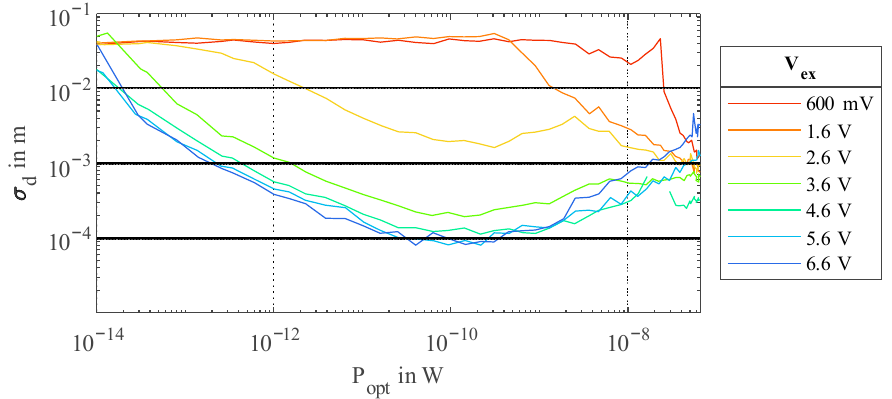
Figure 11. Standard deviation σ d over P opt for different V ex with 32 phase steps and a T int of 1.78 ms.